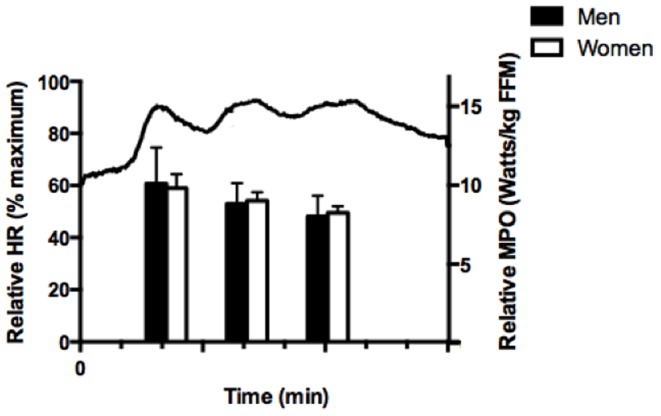
Characterization of the low-volume SIT protocol.Solid line represents average heart rate (HR) response, expressed as a % of maximum, for all subjects during the first training session (left side y-axis). Bar graph represents relative mean power output (MPO) per kilogram fat-free mass (FFM) for men (dark bar) and women (white bar) during the first training session (right side y-axis).